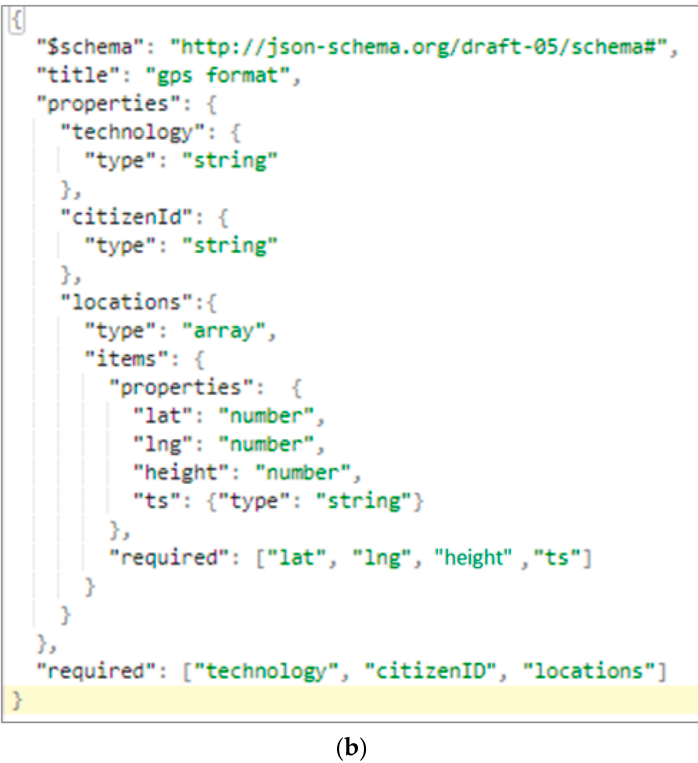
Figure 4. JSON locations Message formats. ( a ) RFID Message Format; ( b ) GPS Message Format.